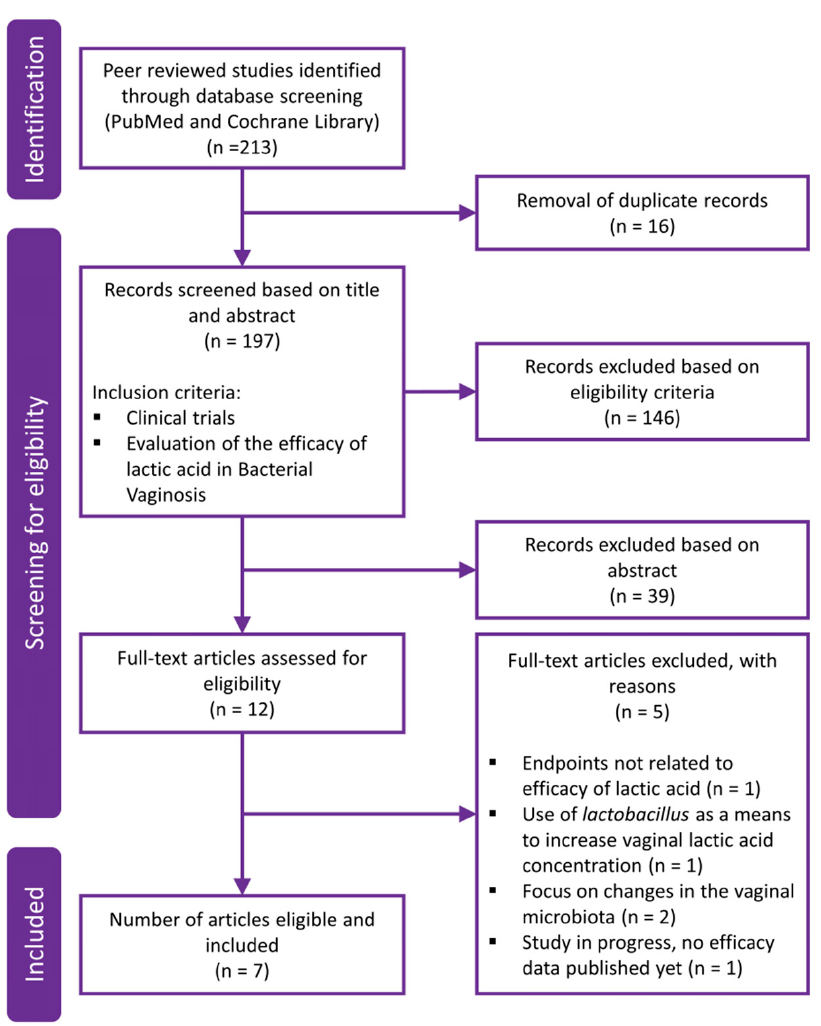
Figure 1. PRISMA flow diagram describing the literature search and article selection process.